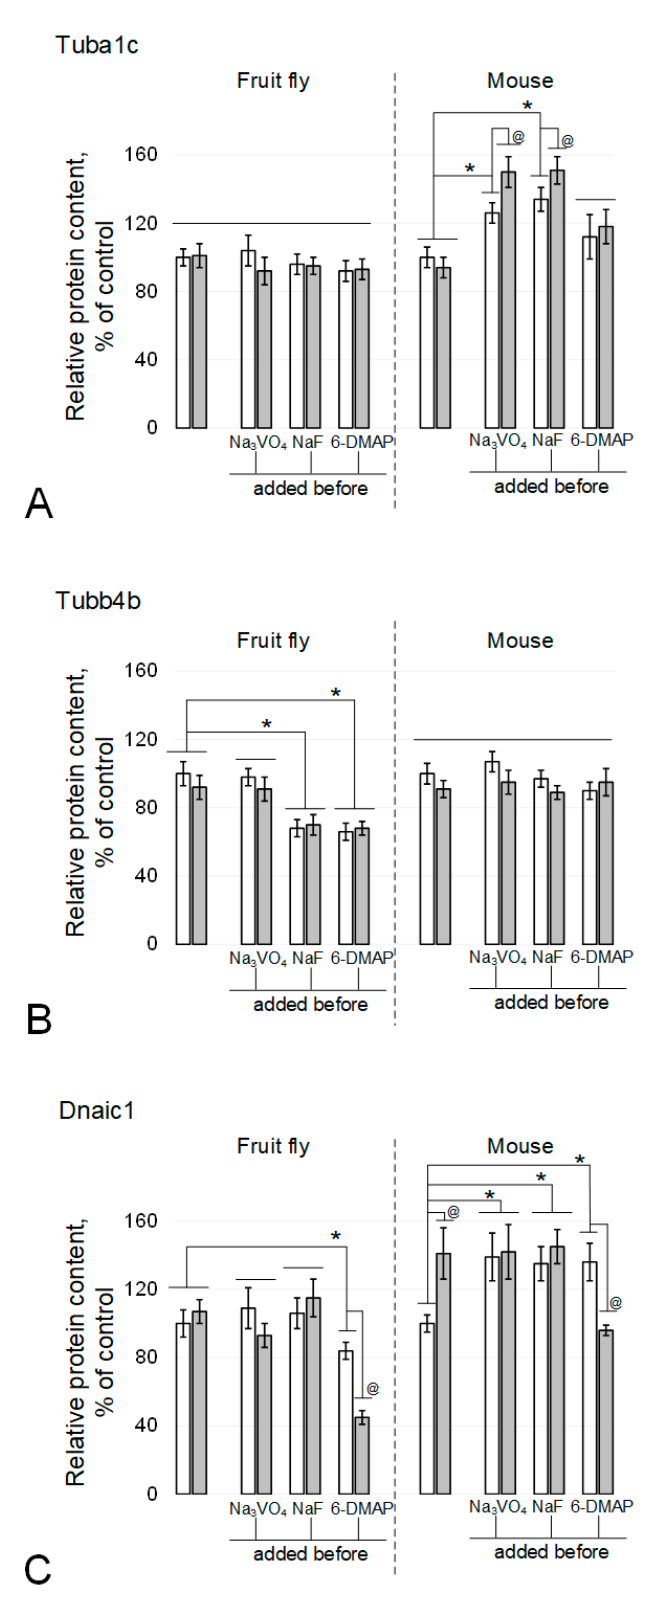
Figure 2. Tubulin isoforms and dynein relative content in the fly and mouse sperm. ( A ) alpha-tubulin Tuba1c. ( B ) beta-tubulin Tubb4b. ( C ) dynein Dnaic1. White columns—control, grey columns—after 6 h exposure under modelling microgravity conditions. @ p < 0.05 in comparison with according control group, * p < 0.05 in comparison with control without any inhibitors.